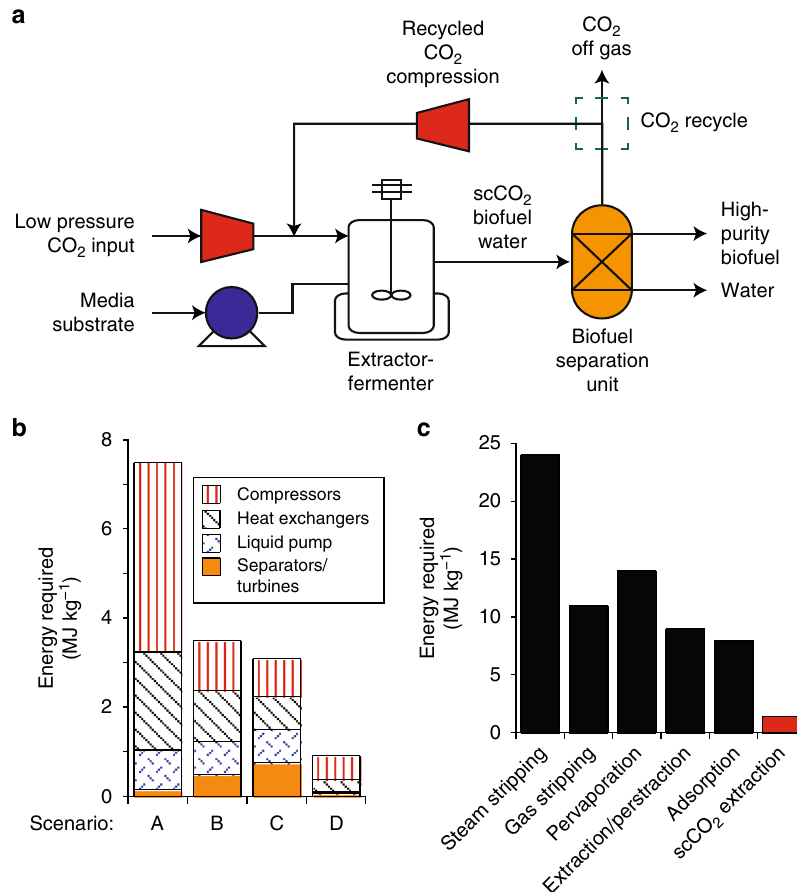
Fig. 5 Isobutanol energy recovery requirements for integrated fermentation-extraction under scCO 2 . a Simpli fi ed process schematic of the envisioned scCO 2 bioprocess used to develop an Aspen Plus model, including compression of CO 2 to scCO 2 , fermentation/extraction, de-pressurization/biofuel recovery, and CO 2 recycle. Further detail is provided in Supplementary Fig. 15a. b Energy requirement for isobutanol recovery as MJ kg − 1 for several scenarios. Separate fermentation and scCO 2 recovery processes represent the base case (scenario A). Scenario B is coupled fermentation and extraction without use of partial extraction stream de-pressurization or scCO 2 recycle. Scenario C de-pressurizes the extraction stream to 6.5 MPa to induce formation of an isobutanol-rich stream, which permits recycling of compressed CO 2 , set at 50% (by mass). Scenario D again de-pressurizes to 6.5 MPa and recycles the maximum possible amount of CO 2 (87%) that results in no accumulation of CO 2 in the system. Values for b can be found in Supplementary Table 6. c Comparison of the energy requirements for isobutanol production found for the scCO 2 process relative to published literature values for alternative in situ recovery methods 28 . The scCO 2 extraction energy requirement in c is for coupled fermentation and extraction with partial de- pressurization and full recycle (i.e., Scenario D in b ). Source data are provided as a Source Data fi